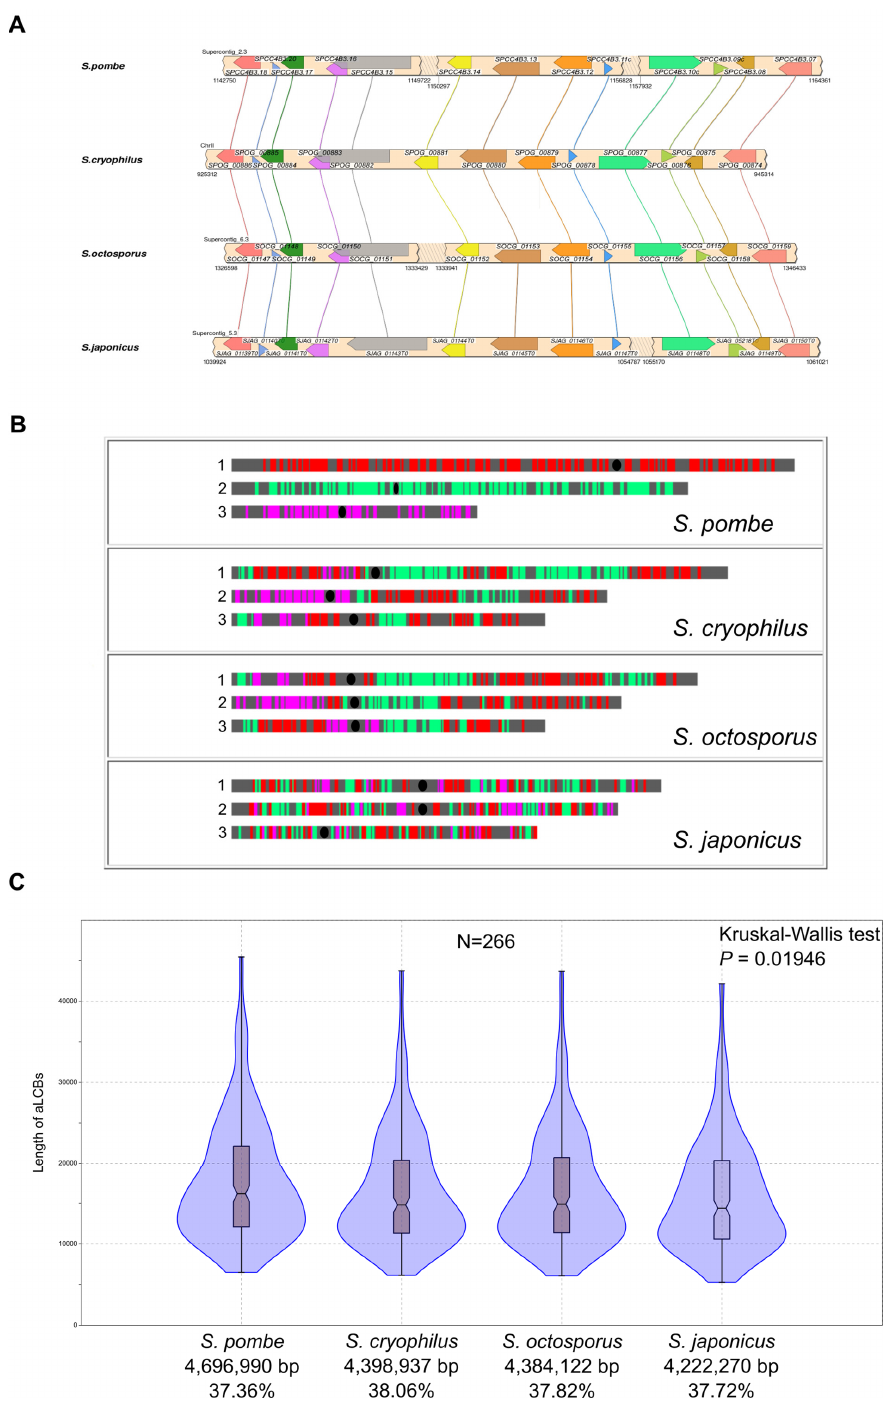
Figure 3. Ancestral locally collinear blocks (aLCBs) of the fission yeasts inherited from their last common ancestor. ( A ) Depiction of a common aLCB from the genomes of the four species. All the genes in the concerning regions were in the same order and orientation. ( B ) Chromosomal localisations of the aLCBs in the species using S. pombe as reference. As was expected, S. japonicus exhibited the most disperse localisation of aLCBs along its chromosomes. Black ellipses indicate centromere positions. ( C ) Length distributions of the inferred aLCBs within the species. Violin plots show kernel density for the samples. Box plots indicate the 25–75 percent quartiles. Horizontal lines within the boxes show the medians of the samples, notches indicate the 95 percent confidence intervals for the medians. Minimal and maximal values are depicted by the whiskers. n : sample size. Values under the species names are the overall lengths of aLCBs and the percentages comparing to the sizes of the whole genomes. As the sizes of the aLCBs included the intergenic regions between coding regions, too, values of S. pombe and S. japonicus were proved to be significantly different. Pairwise statistics (Kolmogorov-Smirnov tests) are presented in Supplementary Figure